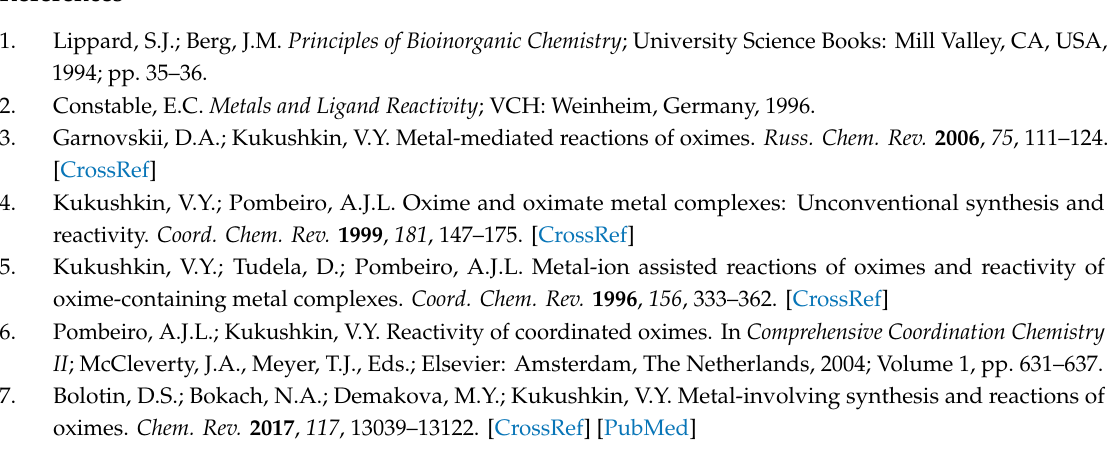
Figure S7: The 13 C NMR spectrum of ClpaoH in d 6 -DMSO; Figure S8: Excitation and emission spectra of L in MeOH. Table S1: Cartesian coordinates and selected energetic data for the species participating in the reaction of ClpaoH and Zn(NO 3 ) 2 · 6H 2 O in MeOH in the presence of Et 3 N; The CIF and the checkCIF output files are included in the Supplementary